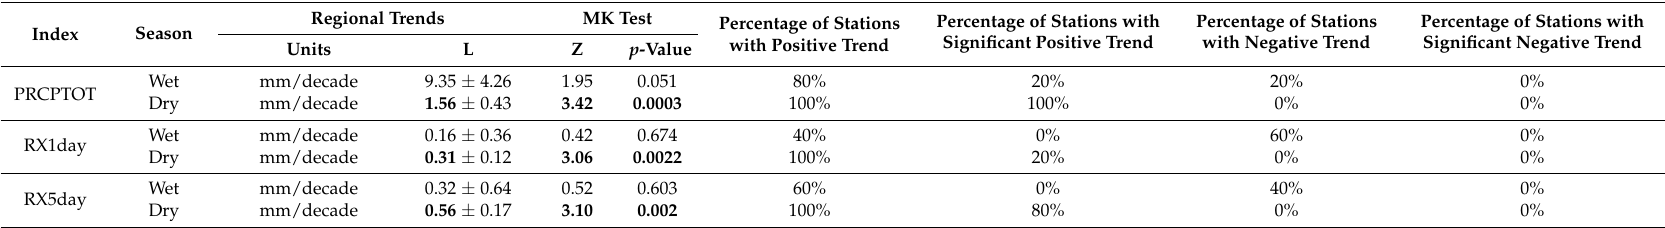
Table 5. Regional trends per decade, results of the Mann–Kendall (MK) test and percentages of stations with positive and negative trends for the seasonal indices (PRCPTOT, RX1day, and RX5day) over the SRYR during 1960–2016.